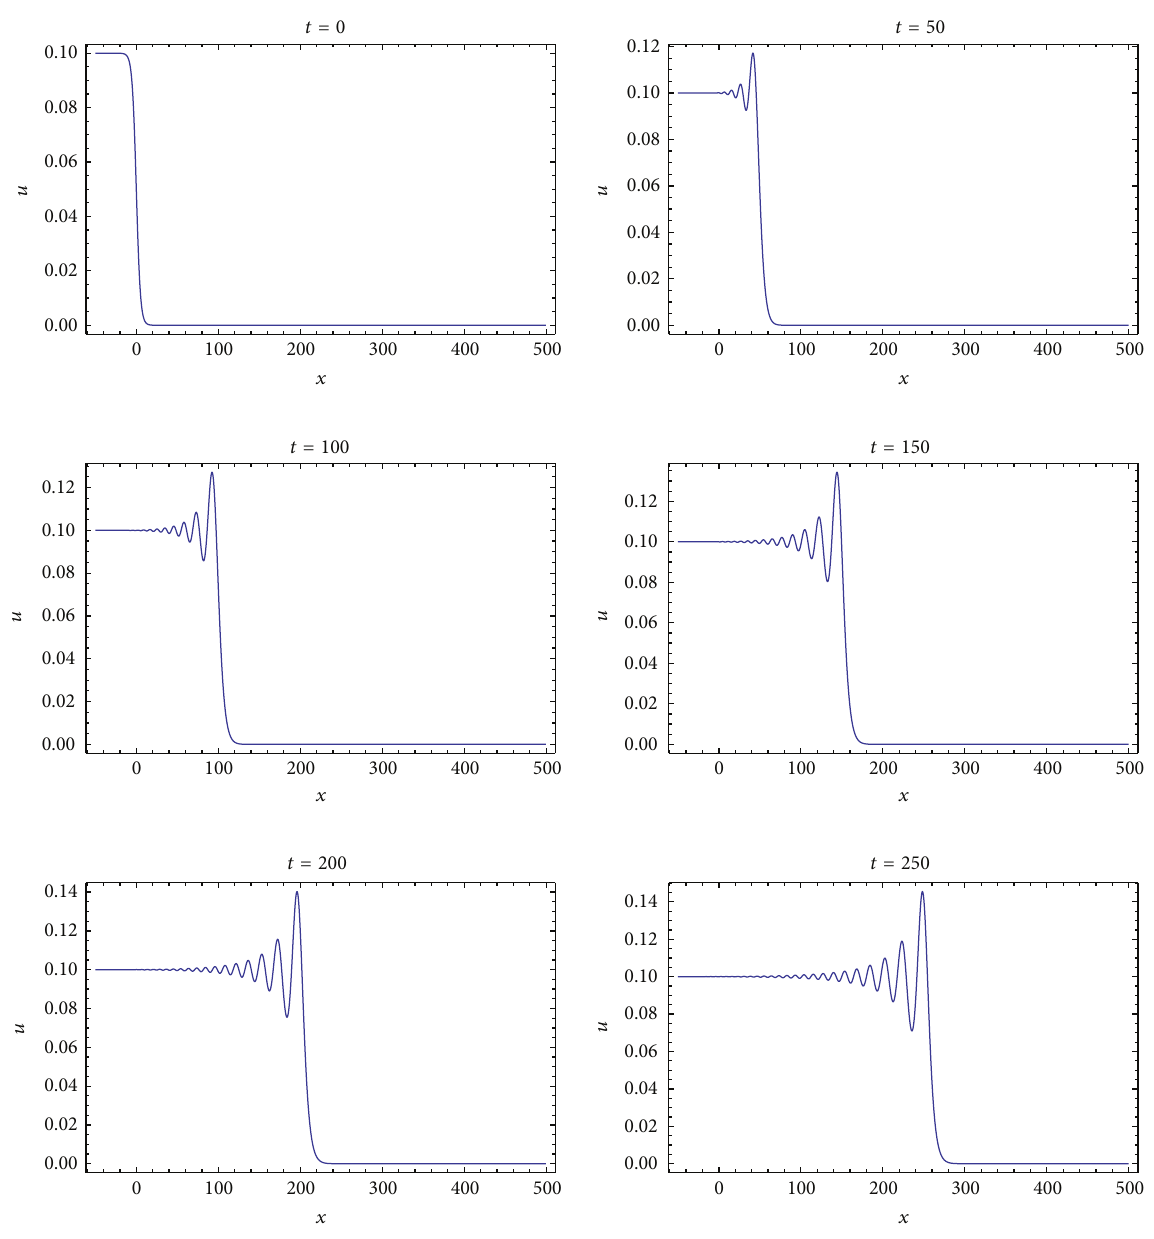
Figure 7: Evolution of initial undular bore (59), where 𝑢 0 = 0.1 , 𝑥 0 = 0 , and 𝛼 = 5 for Δ𝑡 = 0.001 and 𝑛 = 2500 on the interval 𝑥 ∈ [−50, 500] using the nonstandard finite difference scheme